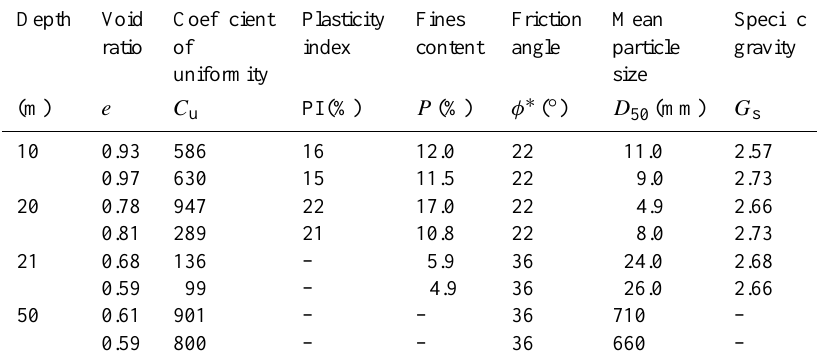
Table 1. Material properties of Tangjiashan Landslide Dam.